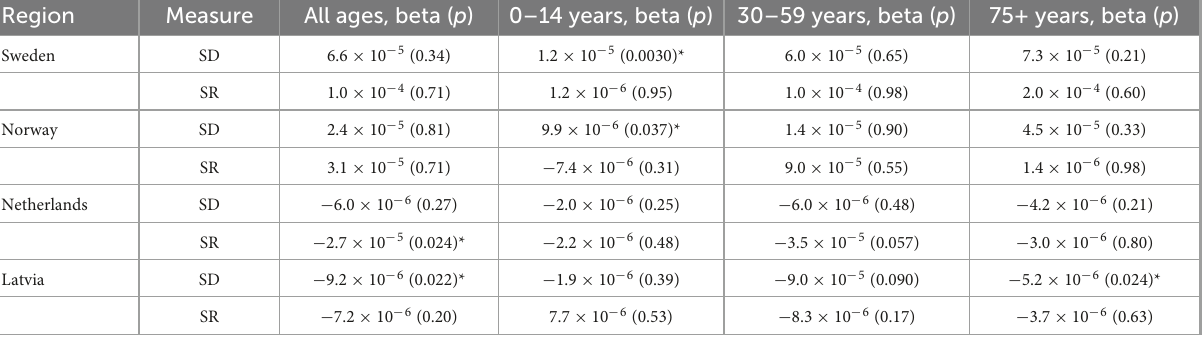
*PRssignificantlydifferentfrom1,i.e.,statisticallysignificantdeviationfromexpectedprevalencenumbers. 1 DuetolimitedageresolutionintheDutchdata,theoldestagegrouppresentedfortheNetherlandsare75+years.Resultsarestratifiedbyageandsex. TABLE 3 Policy predicted common mental disorders (CMD) care prevalence by age groups in all countries. Region Measure All ages, beta ( p ) 75+ years, beta ( p